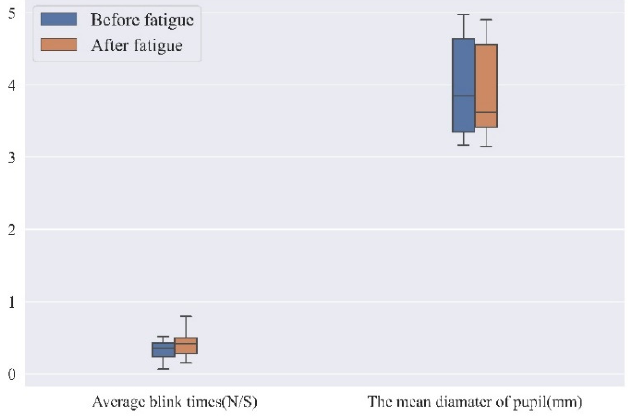
Figure 12. Mean eye movement index.